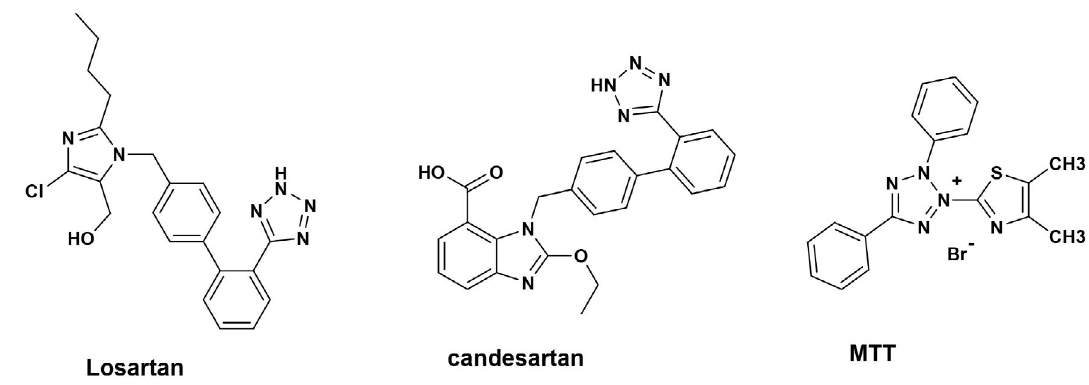
Figure 1. Structure of some of known tetrazol